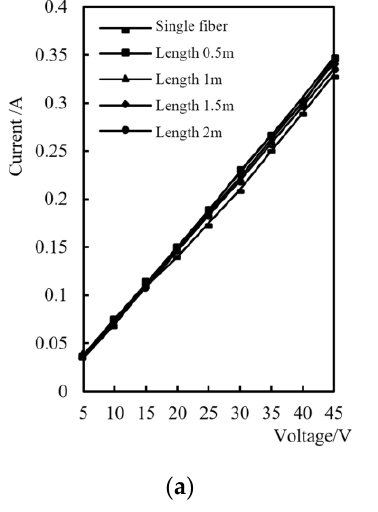
Figure 12. Electrothermal characteristics of multiple heating fibers in parallel. ( a ) Voltage vs. current, ( b ) voltage vs. power per unit area and ( c ) voltage vs. surface temperature.